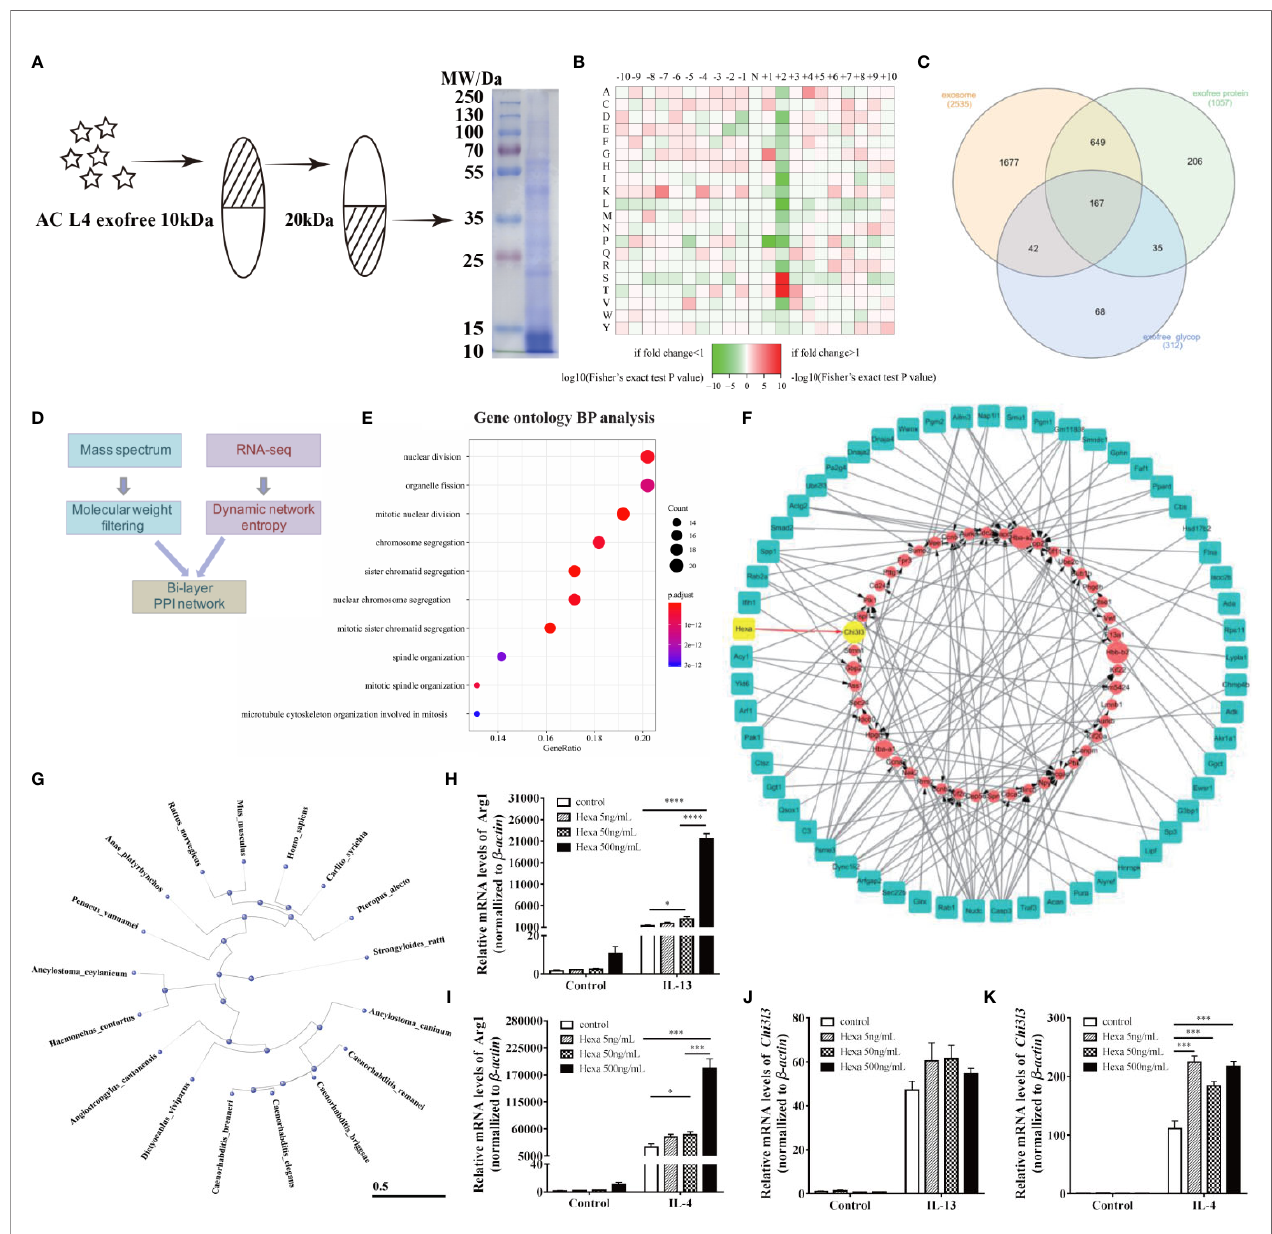
FIGURE 6 | AC-derived Hexa act as a key ingredient in promoting M2 activation of macrophages. (A) Diagram of isolation of 10~20 kDa-AC L4 exofree using ultra fi ltration tubes, and the ef fi ciency was con fi rmed using western blot. (B) Heatmap showed the relative frequencies of amino acids between the asparagine (Asn) position of N-linked glycoproteins in AC L4 exofree. Enrichment level of the amino acid at indicate position is shown in different colors. Red means high enrichment level, and green means low enrichment level. (C) Venn diagram of AC L4 exosome, AC L4 exofree proteins identi fi ed using mass spectrum analysis. (D) Diagram of Bi-layer PPI network analysis using AC L4 exofree proteins and RNA-seq data of BMDMs. (E) GO enrichment analysis (Biological process) of exofree-induced TCGs of BMDMs ( Supplementary Figure 5B ). (F) A protein-gene network was constructed for worm proteins with molecular weight less than 50kDa and TCGs of exofree-, IL-4-, and exofree+IL-4-treated BMDMs ( Supplementary Figure 5A ), based on the LC-MS/MS and RNA-seq data. (G) Phylogene tree of Hexa protein in 17 species. (H, J) qPCR analysis of mRNA level of Arg1 (H) and Chi3l3 (J) were measured in the presence of PBS, Hexa 5 ng/ml, Hexa 50 ng/ml, Hexa 500 ng/ml, IL-13 10 ng/ml, IL-13+Hexa 5 ng/ml, IL-13+Hexa 50 ng/ml, IL-13+Hexa 500 ng/ml for 24 h. (I, K) qPCR analysis of mRNA level of Arg1 (I) and Chi3l3 (K) were measured in the presence of PBS, Hexa 5 ng/ml, Hexa 50 ng/ml, Hexa 500 ng/ml, IL-4 10 ng/ml, IL-4+Hexa 5 ng/ml, IL-4+Hexa 50 ng/ml, IL-4+Hexa 500 ng/ml for 24 h. Data information: *P <0.05, ***P <0.001, ****P